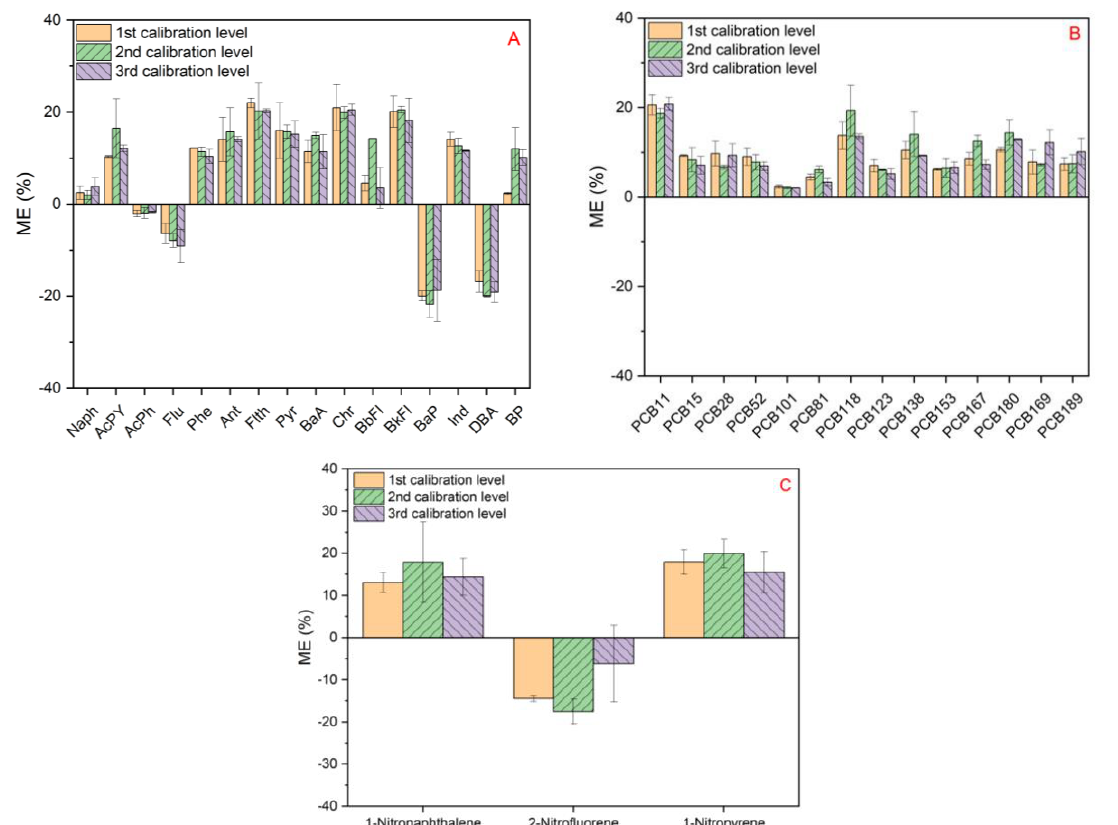
Figure 3. Matrix effect (ME) of the developed QuEChERS method for PAHs ( A ), PCBs ( B ) and nitro-PAHs ( C ) over three calibration levels (summarized in Section 2.4.3).